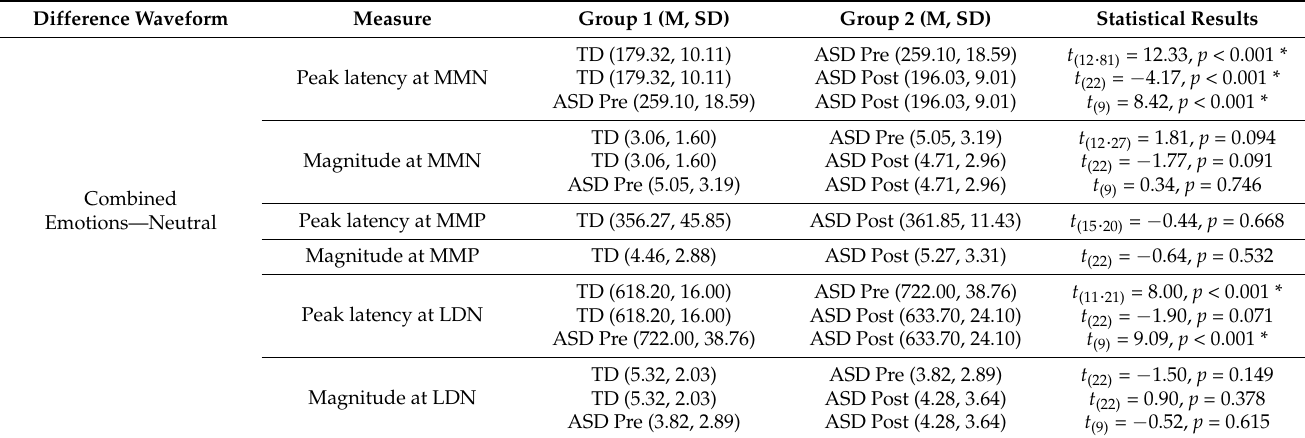
Table 2. Comparative analyses of peak latency and MMR magnitude data between three participant groups (TD, ASD pre-intervention, and ASD post-intervention) for combined emotions difference waveforms. * denotes group differences at a significance level of p ≤